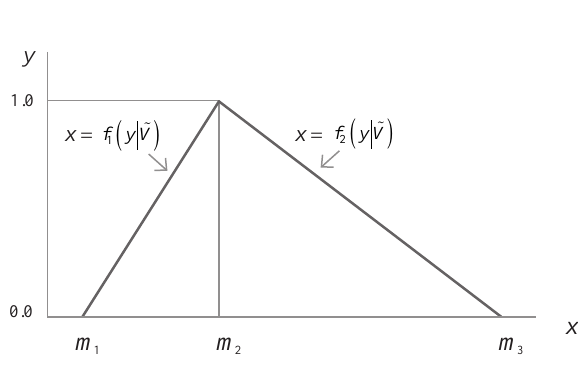
Fig. 1. A flat fuzzy number,  V